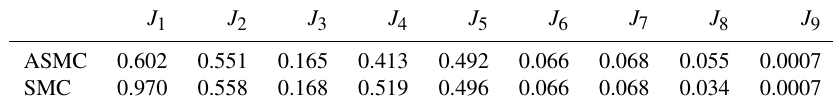
Table 3. Values of performance indices of the SMC and ASMC during the 1940 El Centro earthquake. J